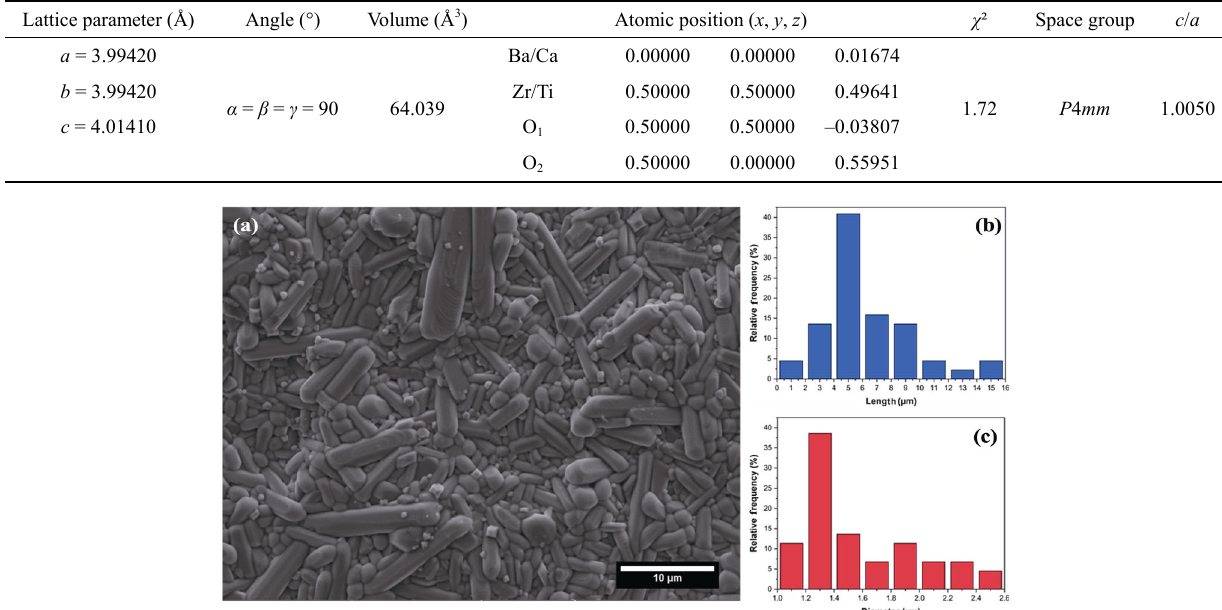
Fig. 3 (a) SEM micrograph and corresponding statistical distribution of (b) length and (c) diameter of BCZT ceramics sintered at 1250 ℃ /10